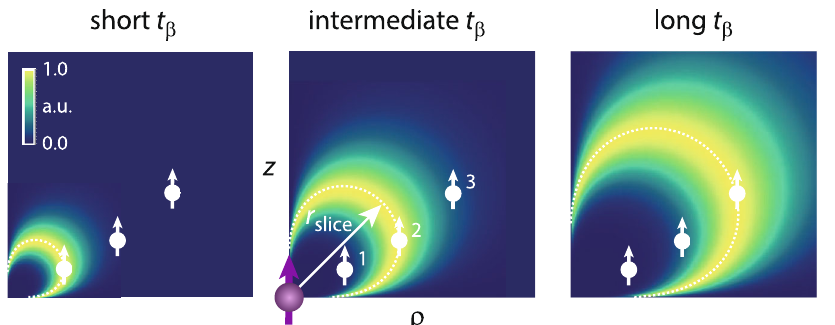
Fig. 3 Simulation of the sensitive slice S ð r Þ . ρ z -plot of the sensitive slice for different interaction times t β , where z ¼ r cos ϑ and ρ ¼ r sin ϑ are vertical and radial distance, respectively. Bright shading color codes the signal-to-noise ratio. By varying t β the sensitive slice can be tuned to spins in close (1), intermediate (2), or far (3) distance from the central electronic spin (panels from left to right). The dashed contour is the a ⊥ isoline where β = β (opt) . r slice is the characteristic radius of a slice. Plots assume t ℓ = 0 and ð T (cid:6) Þ (cid:3) 1 2 ; n